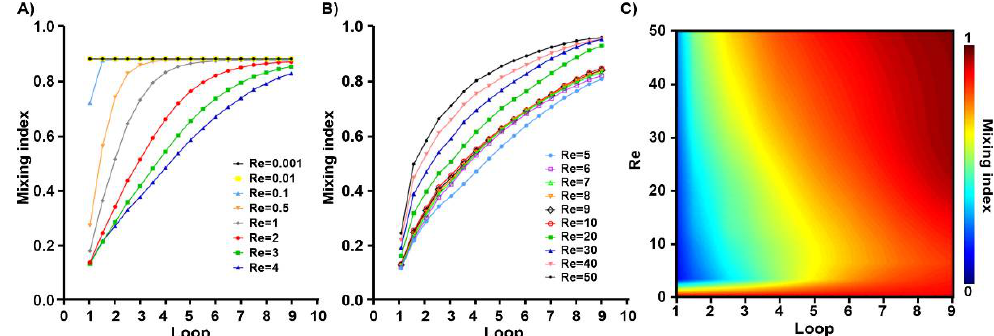
Figure 7. The mixing trend index for SM3 loops and Reynolds numbers. The mixing index growth over the length ( A ) before Re = 5; ( B ) after Re = 5; ( C ) the mixing contour along the spiral loops is shown for all of the applied flow rates. Very low and high velocities show proper mixing in fewer loops. No further mixing occurs after the initial loops in high Re , benefiting the fabrication and application requirements.